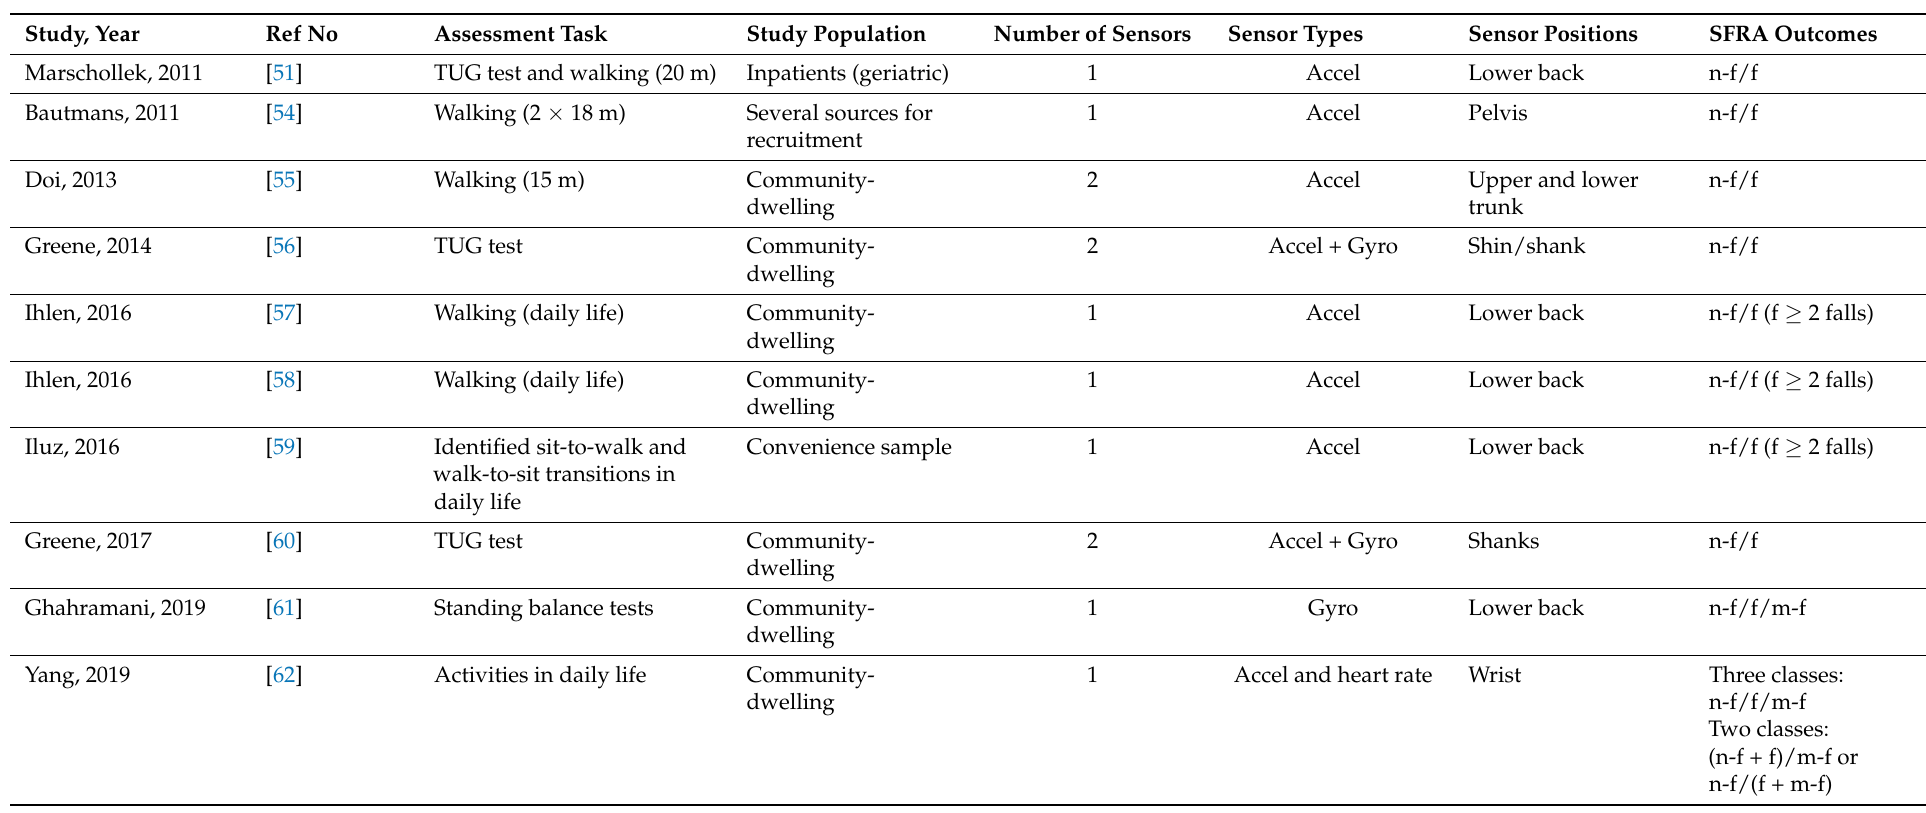
Table 2. SFRA methods identified in [47] and considered to be relevant for the orthopedic clinic and the two selected clinical FRA situations from sub-study 1. n-f: non-faller; f: faller; m-f: multiple-faller; Accel: 3D accelerometer; Gyro: 3D gyroscope; TUG: Timed Up and